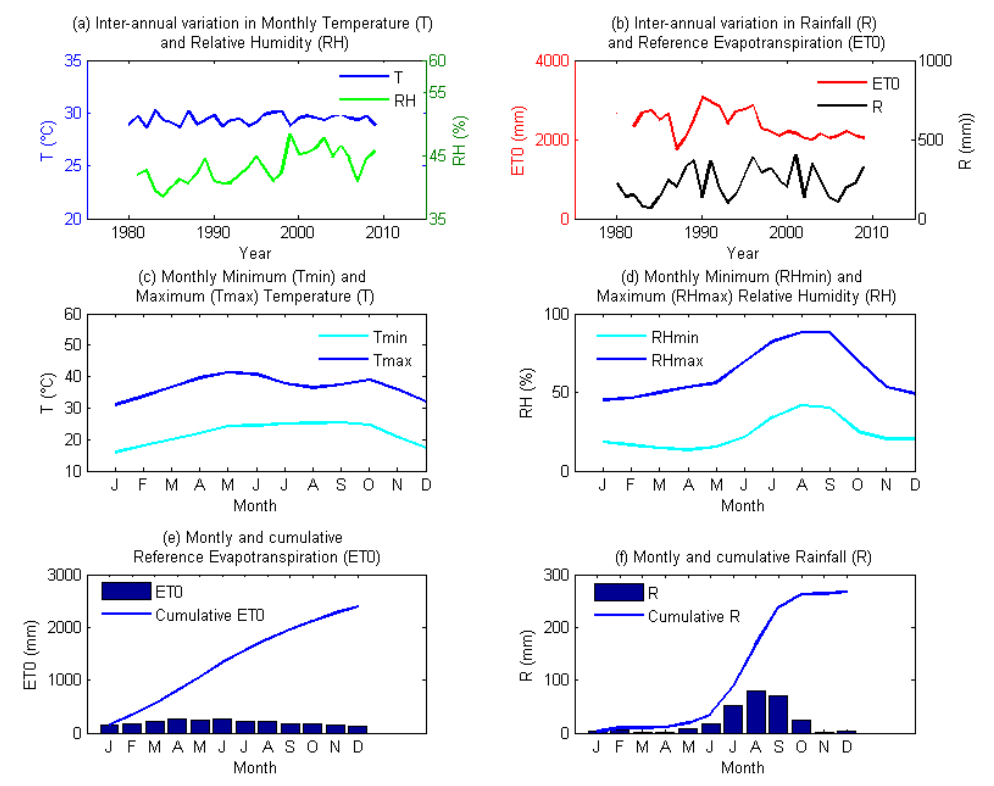
Figure 3. Climatic parameters and reference evapotranspiration (computed using the FAO (Food and Agriculture Organization) guidelines) in Podor (1980–2009); inter-annual variation in temperature and relative humidity ( a ), rainfall and reference evapotranspiration ( b ); monthly minimum and maximum temperature ( c ) and relative humidity ( d ); monthly and cumulative reference evapotranspiration ( e ) and rainfall ( f ). Data source: Agence Nationale de l’Aviation Civile et de la Météorologie (ANACIM).